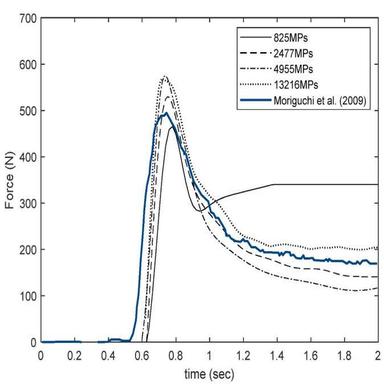
Sensitivity study on the number of MPs/cell for mesh size equal to 0.0085 m